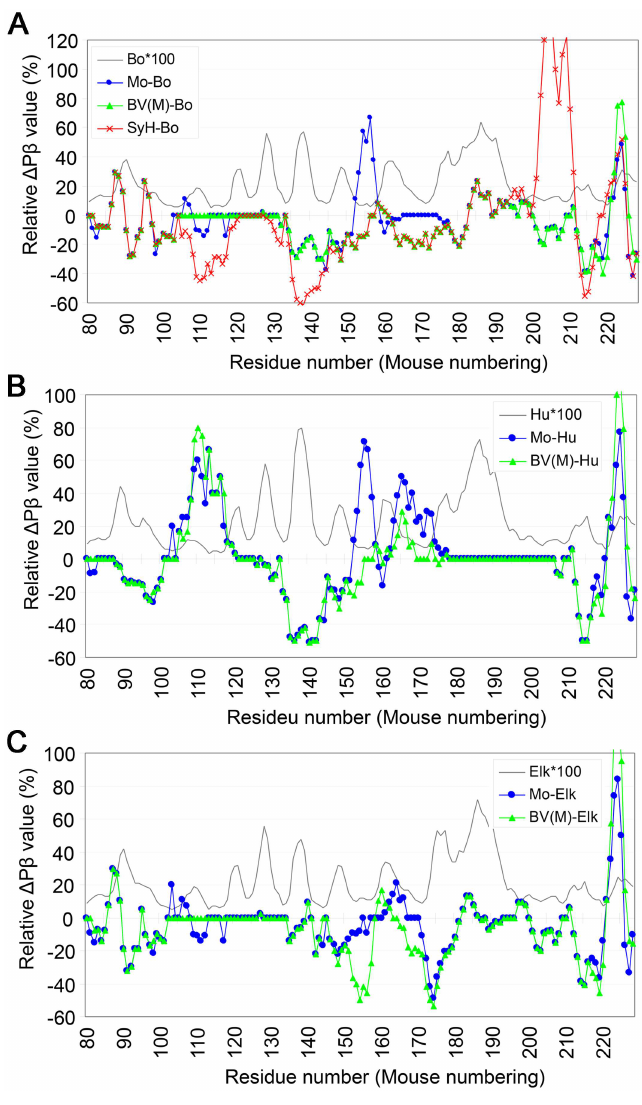
Fig 5. Relative Δ P β graphs can reveal subtle differences in P β among PrPs from different species. A . Δ P β graphs of PrP from mouse (Mo), Syrian hamster (SyH) and bank vole with methionine at the polymorphic codon109 [BV(M)] relative to bovinePrP (Bo). The gray curve without any marker represents a P β graph of bovinePrP, multiplied by 100 to enablecomparisons with the Δ P β -graphs (Bo * 100). B and C . Comparisons of Δ P β -graphs of mouse and bank vole with M109 relative to humanPrP ( B ) and elk PrP ( C ). The relative Δ P β -graph patterns differed substantially dependingon the species used for